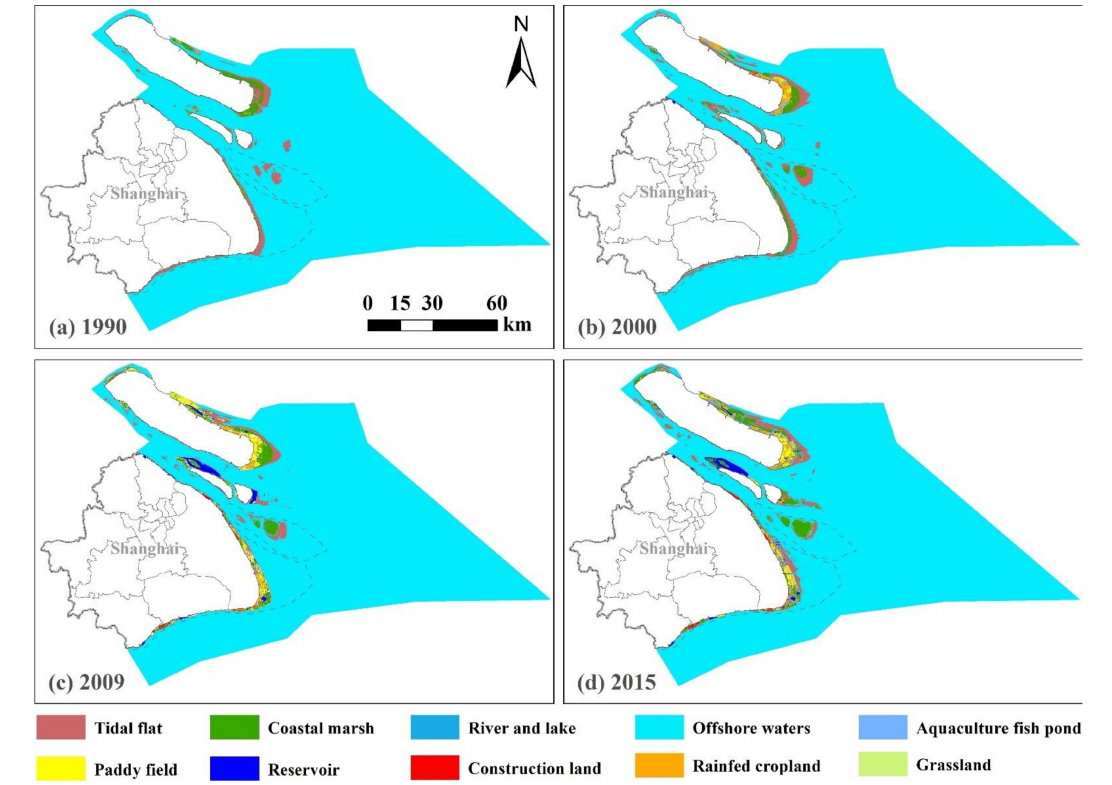
Figure 2. The distribution of the land use/land cover types along the Shanghai coastal area from 1990 to 2015. ( a ) The spatial distribution of land use/land cover types in the study area in 1990. ( b ) The spatial distribution of land use/land covers in the study area in 2000. ( c ) The spatial distribution of land use/land cover types in the study area in 2009. ( d ) The spatial distribution of land use/land cover types in the study area in